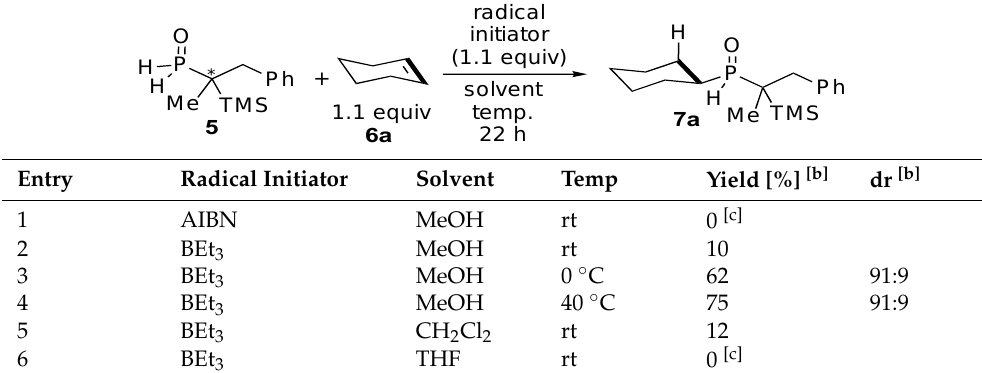
Table 1. Optimization of radical addition [a].